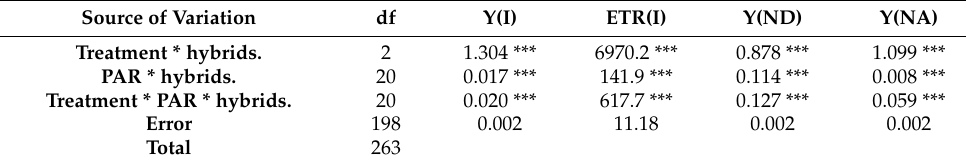
Table 3. Cont. Source of Variation Treatment * hybrids.